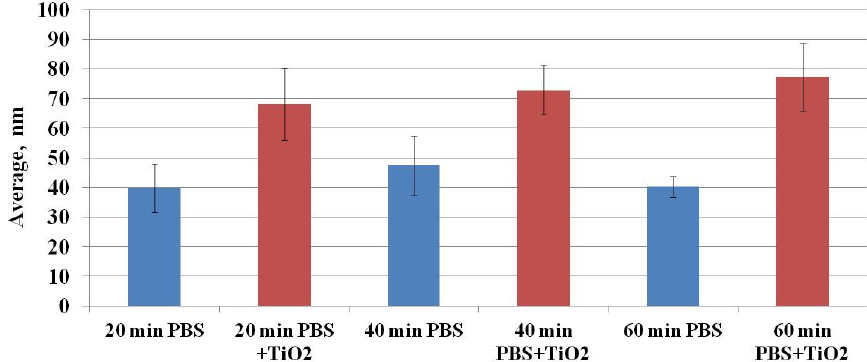
Figure 9. The dependence of the average surface roughness factor on the exposure time of CHO cells to TiO 2 -NPs.